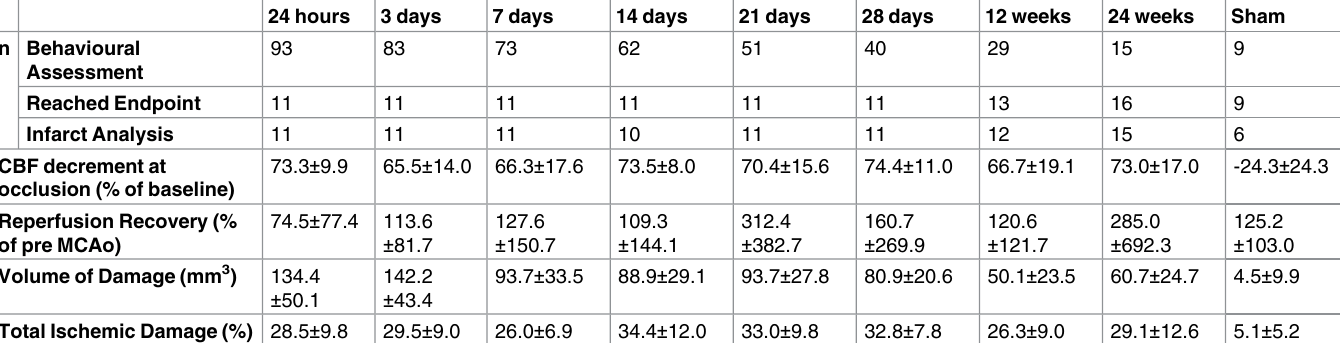
Table 2. Summaryof cohort sizes, CBF drop at MCAo and Tissue Damage (Mean ± Standard